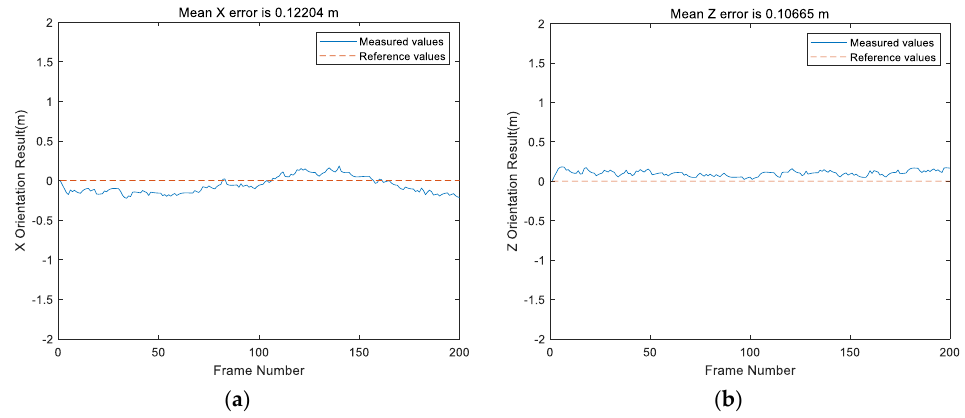
Figure 12. The strong tracking kalman filter (STKF) positioning results under the source rotation for the point (0, 0). ( a ) Error in the x–direction. ( b ) Error in the z–direction.